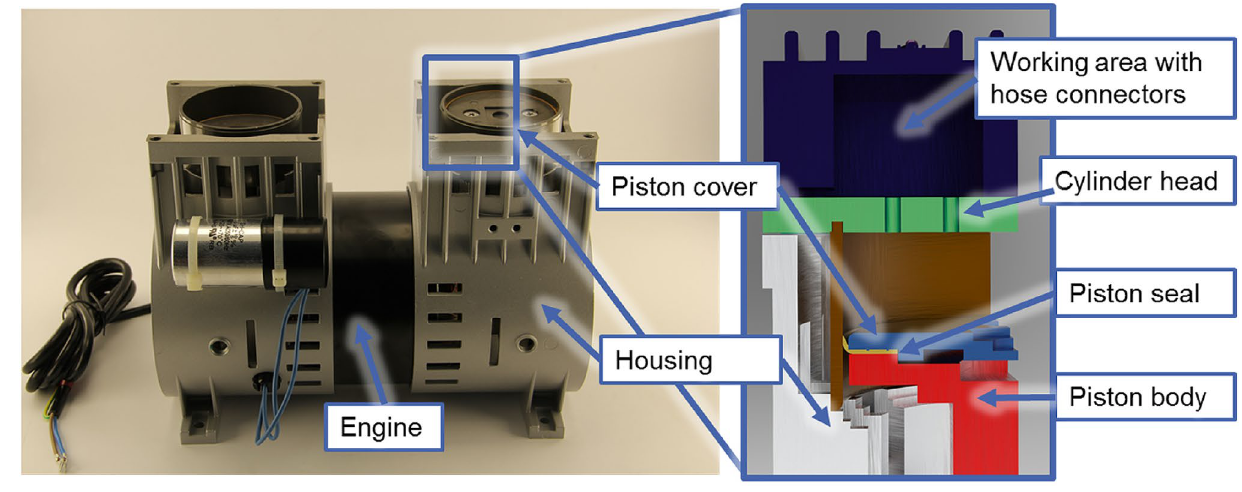
Fig. 11 An element of the reference system: oil-free piston pump from a competitor